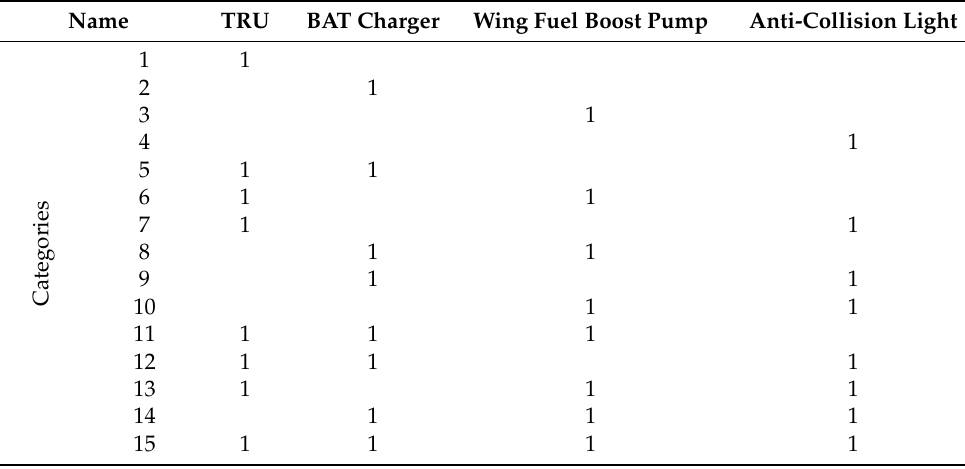
Table 1. Load working combination